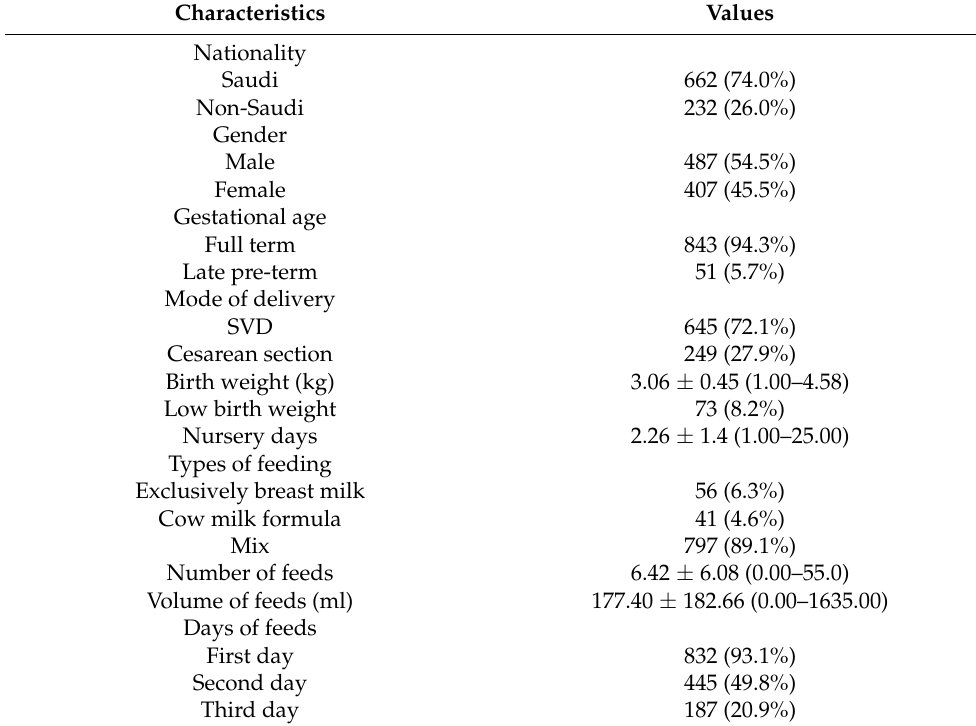
Table 1. Characteristics of all the newborns ( n = 894). Characteristics